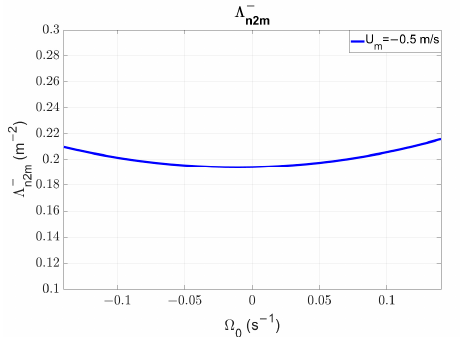
Figure 15. 𝛤 (stream function coefficient) and 𝛬 (surface elevation coefficient) of the nm-negative interaction component as functions of vorticity. Figure 16. 𝛤 (stream function coefficient) and 𝛬 (surface elevation coefficient) of the n2m-negative interaction component as functions of vorticity.